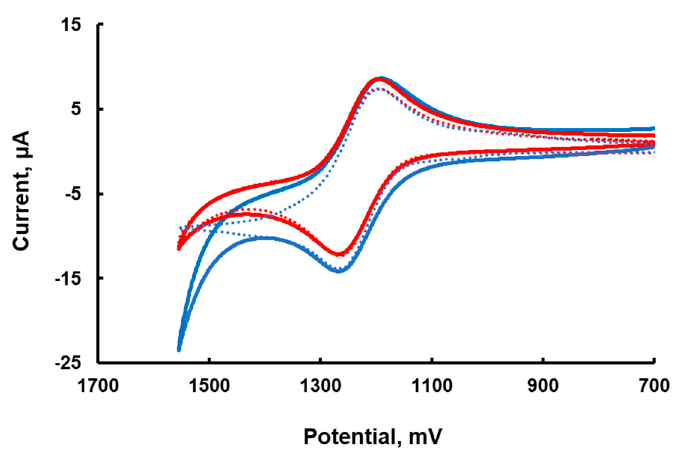
Figure 1. Cyclic voltammograms of 1.0 mM [Ru(bpy) 3 ]Cl 2 in 80 mM sodium phosphate at pH 7.2 (red) and in the presence of 15 μ M Ru 4 POM (blue); the simulated curves are dotted lines. Scan rate, 100 mV/s; potential versus SHE.